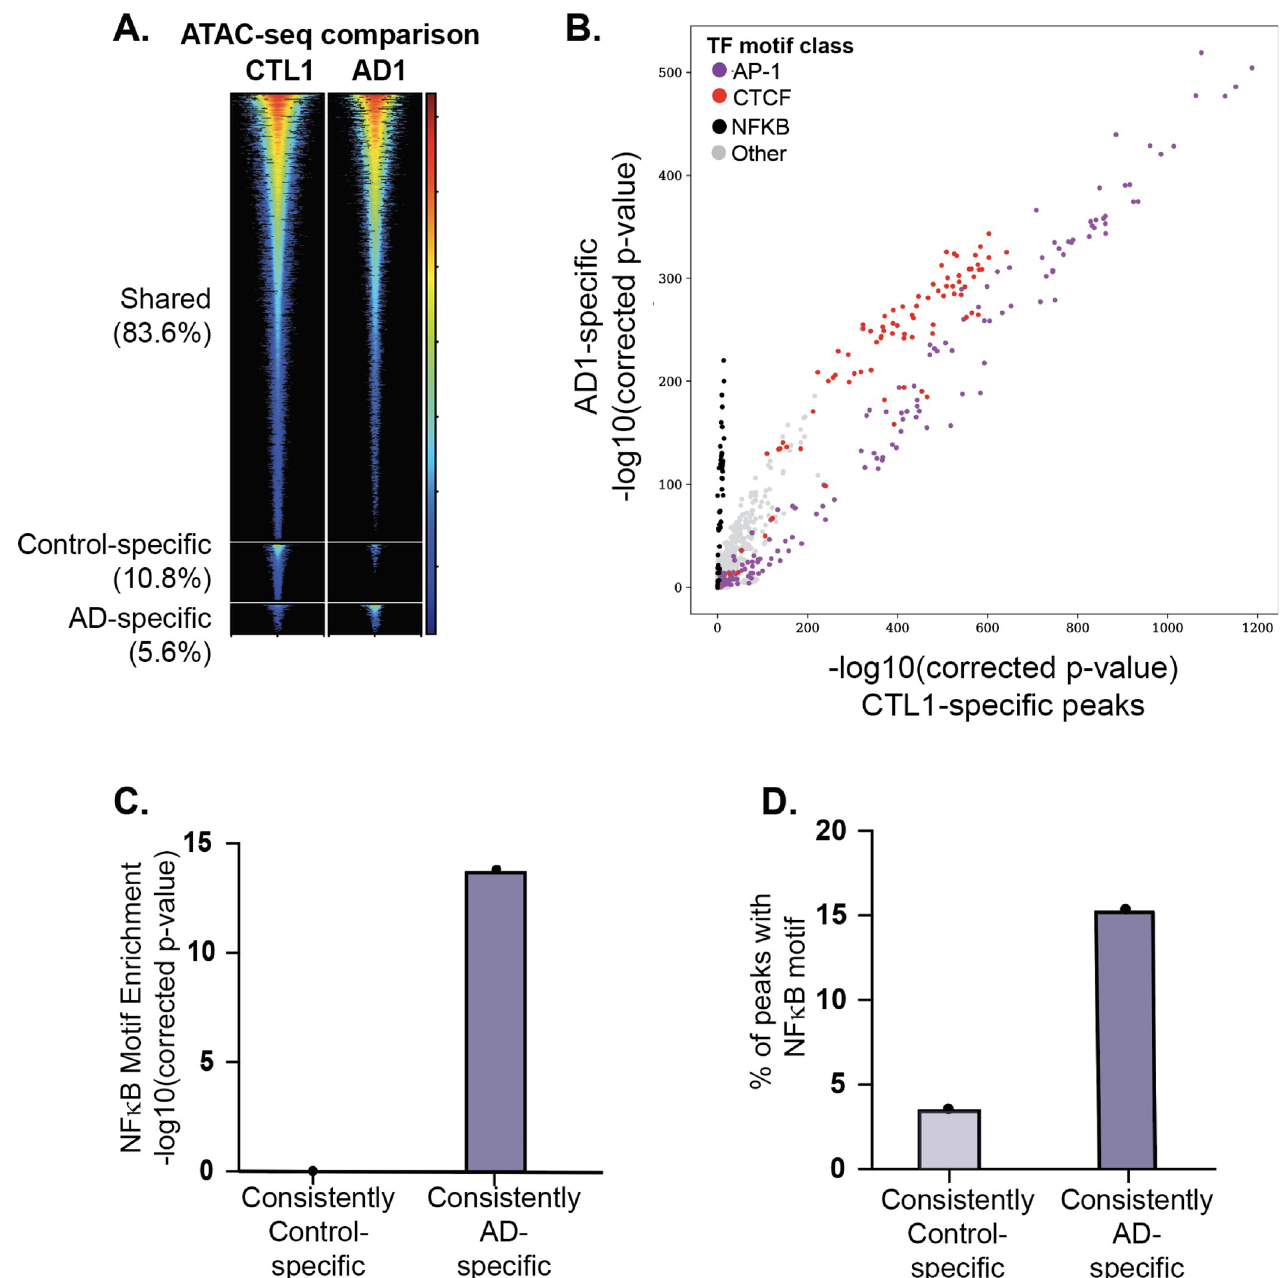
Fig 2. Differential chromatin accessibility and transcription factor (TF) motif enrichment in atopic dermatitis (AD) subjects vs. matched controls. Assay for transposase-accessible chromatin sequencing (ATAC-seq) peaks were identified for all cases and controls and compared for all subject pairs. (A) Differential chromatin accessibility analysis. For each matched pair of subjects, we identified shared, control-specific, and AD-specific peaks (see METHODS). A representative subject pair is shown in (A). Each row represents a single genomic locus where an ATAC-seq peak was identified in either the AD or control subject. The center of each row corresponds to the center of the ATAC-seq peak. Heatmap colors indicate the normalized ATAC-seq read count within the AD1 (right) or CTL1 (control) (left) subject–see key on the right. (B) Differential transcriptional factor (TF) motif enrichment analysis. Comparison of TF motif enrichment results within a representative AD-specific and control-specific matched subject pair. Each dot represents the enrichment of a particular motif (corrected negative log 10 p-value). Select motif families are color-coded (see key on the upper left side). (C and D) Nuclear factor kappa B (NFKB) motif enrichment comparison between consistently AD-specific and consistently control-specific ATAC-seq peaks. “Consistently specific” peaks were defined as those peaks that were AD- or control-specific in at least three AD or control subjects, respectively. Results are shown for representative Cis-BP NFKB motif, M05887_2.00. Full results are provided in S5 Table